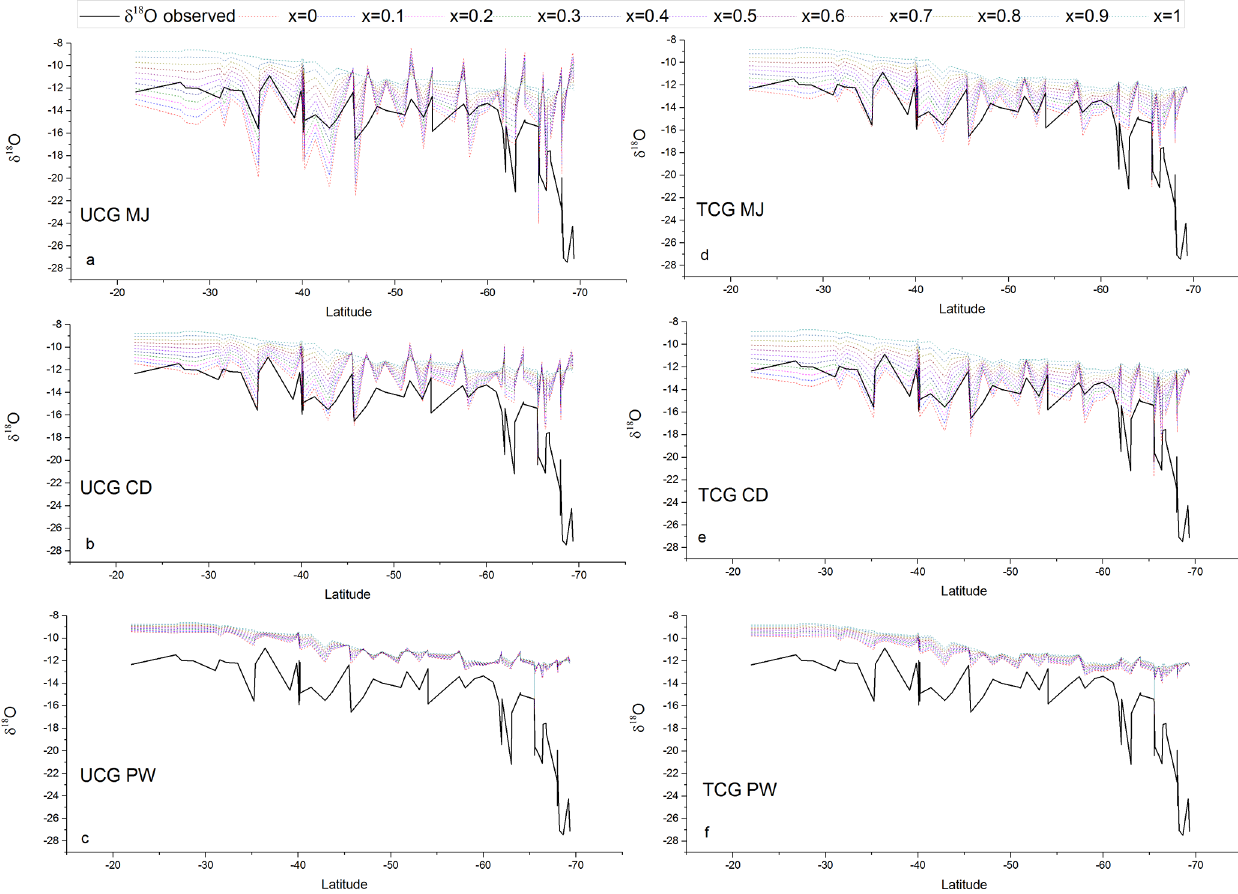
Figure 7. Comparison between the latitudinal distribution of the measured water vapor δ 18 O (black lines) and that predicted by the TCG and UCG models, employing the global closure assumption for different molecular diffusivity ratios and turbulence indices, shown as colored lines.